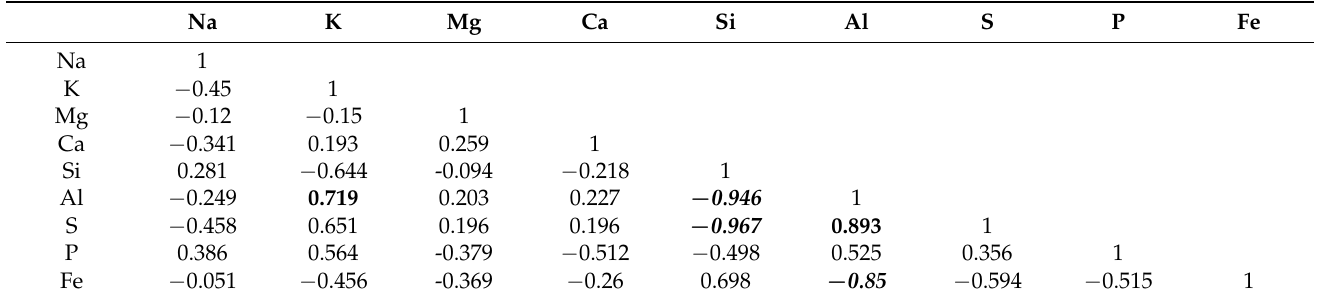
Table 10. The correlation matrix of the average atomic ratio values of sets of belites from eight experimental samples with different input sulfur content and lime saturation values. The critical value of Pearson’s correlation coefficient is ± 0.703 ( ν = 8, α = 0.05, two-tailed); significant values are typed bold (significant positive correlation) or bold italics (significant negative